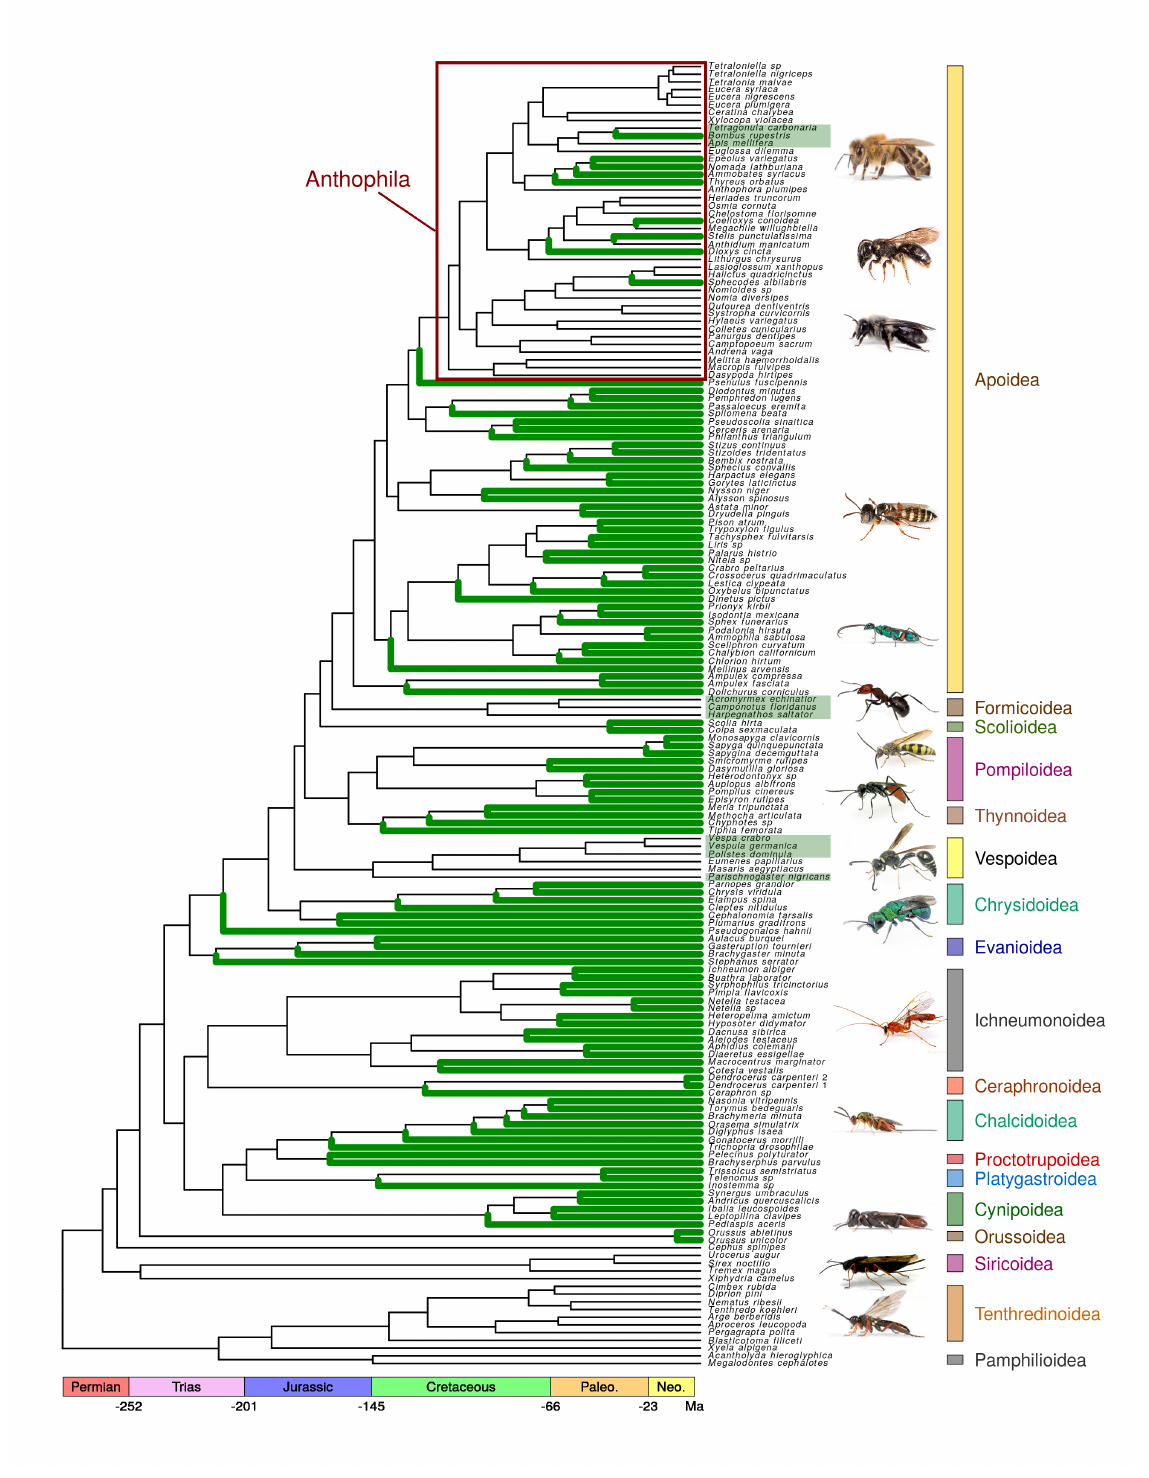
Figure S3 – Parasitic species in the dataset. Parasitics species (parasitoids, parasites of plants and social parasites) are indicated by green terminal branches. Green rectangles around labels indicate eusocial